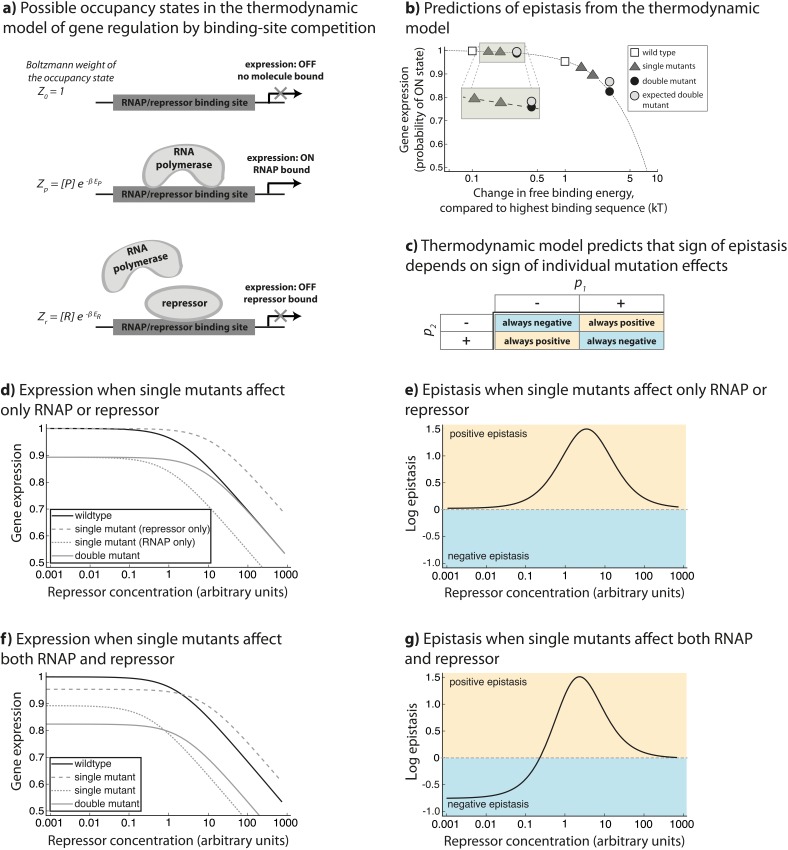
Overview of the generic model.The theoretical approach used in this study, originally developed to describe gene regulation by the lambda bacteriophage repressor CI (Ackers et al., 1982), relies on statistical thermodynamics assumptions to model initiation of transcription. (a) In this framework, each DNA-binding protein is assigned a binding energy (Ei) to an arbitrary stretch of DNA. Given a set of DNA-binding proteins (a generic RNAP-like and a generic repressor-like TF, in this case) and a promoter sequence, a Boltzmann weight can be assigned to any configuration of these TFs on the promoter. By assigning a Boltzmann weight to all configurations, one can calculate the probability of finding the system in a configuration that leads to the initiation of transcription. (b) When considering only the binding of a single protein to DNA (for example ‘RNAP’ only), if mutations have a negative effect on protein-DNA binding, the model predicts negative epistasis between them in terms of expression. This prediction arises from the non-linear relationship between binding energy and gene expression pon (dotted line). In this illustration, we show a relative change in binding energy compared to the sequence with highest possible binding, in kT. (c) By generalizing the properties of the relationship between binding and gene expression, we conclude that the sign of epistasis depends only on the sign of individual mutation effects (p1 and p2) upon binding. When both ‘RNAP’ and ‘repressor’ are present in the system, epistasis depends on the ‘repressor’ concentration and the magnitude of single mutation effects on ‘RNAP’ and ‘repressor’ binding (d,e,f,g). (d) One point mutation negatively affects only ‘RNAP’ binding, while the other only ‘repressor’ binding. (e) Under such circumstances, the system shows no epistasis at low ‘repressor’ concentrations, but is in positive epistasis when ‘repressor’ concentration increases. Finally, at very high repressor concentrations, epistasis approaches 0. (f) Point mutations negatively affect both ‘RNAP’ and ‘repressor’ binding. (g) Under such conditions, epistasis changes the sign from negative to positive as repressor concentration increases.